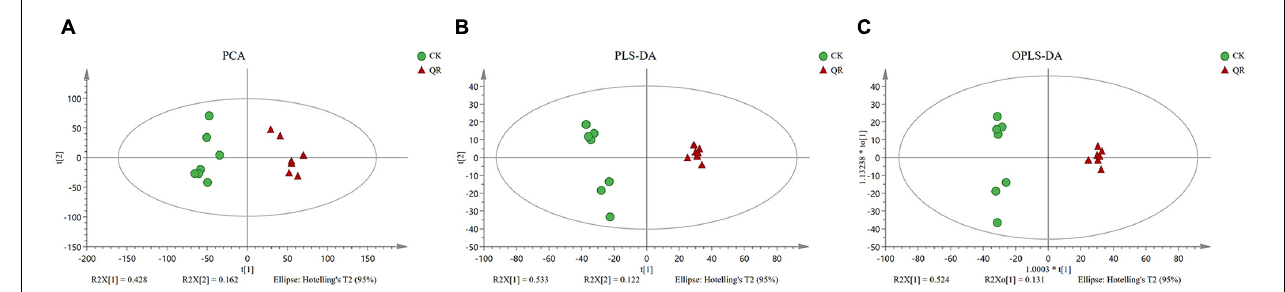
FIGURE 2 | Multivariate analysis of UPLC-MS data. (A) PCA; (B) PLS-DA; (C) OPLS-DA. The green circles and the red triangles, respectively, stand for seven biological replicates in the QR and the control groups.